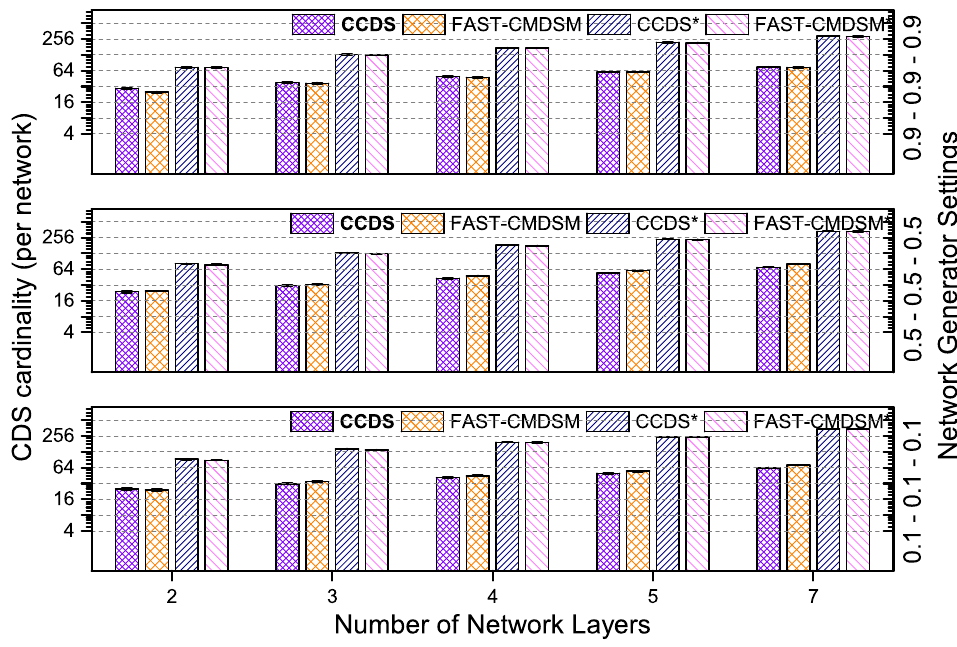
Figure 13. Impact of number of layers (CDS size aggregated over all